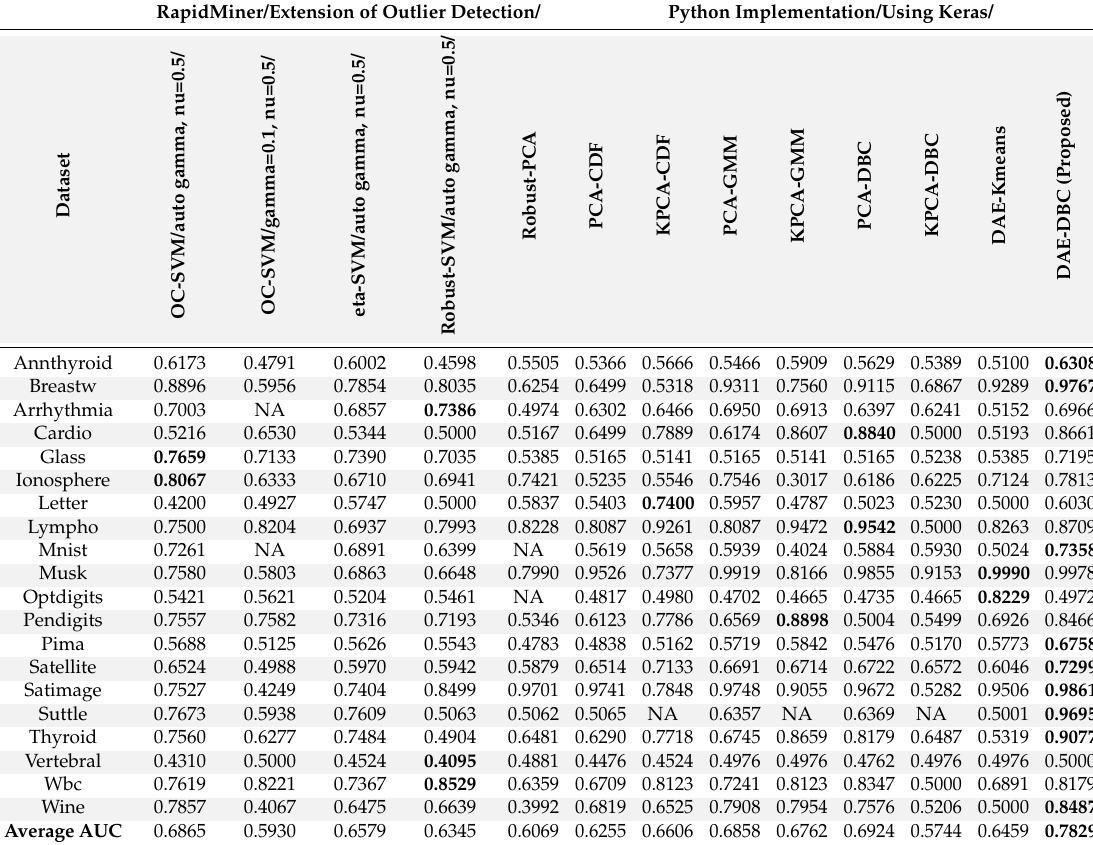
Table 3. AUC score of compared methods on benchmark datasets. The highest values of AUC scores are marked in bold. RapidMiner/Extension of Outlier Detection/ Python Implementation/Using